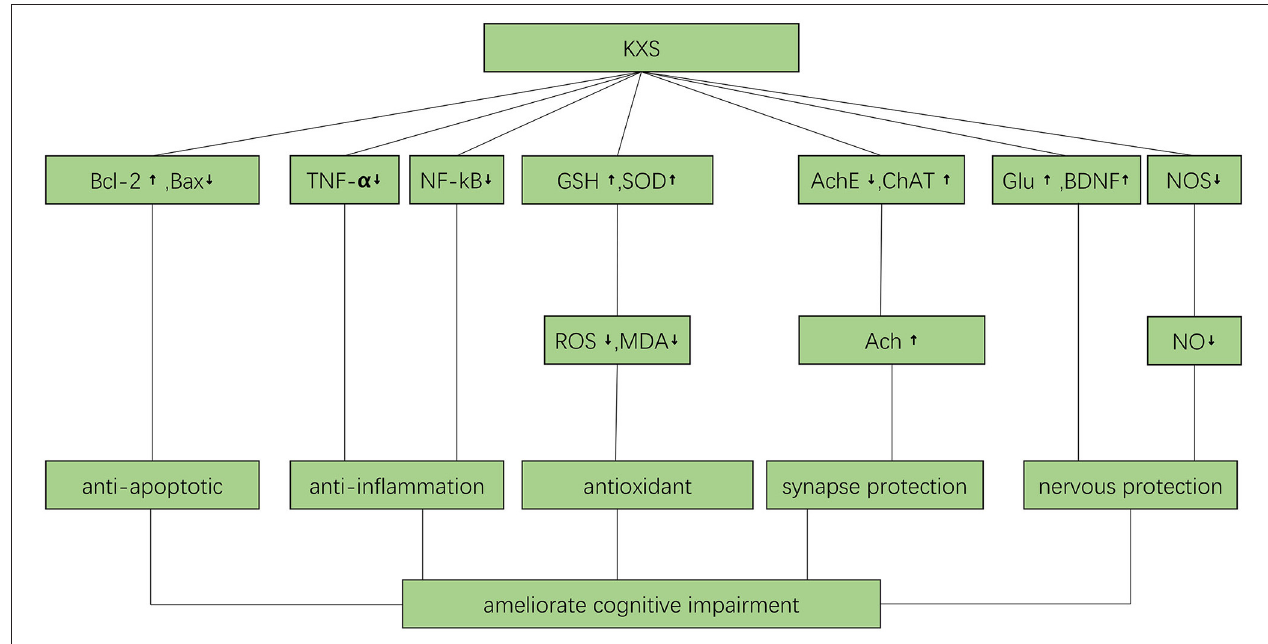
FIGURE 8 | The possible mechanisms by which KXS may improve cognitive function. Ach, acetylcholine; AchE, Acetyl cholinesterase; BDNF, brain derived neurotrophic factor; ChAT, choline acetyltransferase; Glu, Glucose; GSH, glutathione; MDA, malondialdehyde; NF-kB, nuclear factor-k-gene binding; NO, Nitric oxide; NOS, Nitric oxide synthase; ROS, reactive oxygen species; SOD, superoxide dismutase; TNF- α , Tumor Necrosis Factor α .